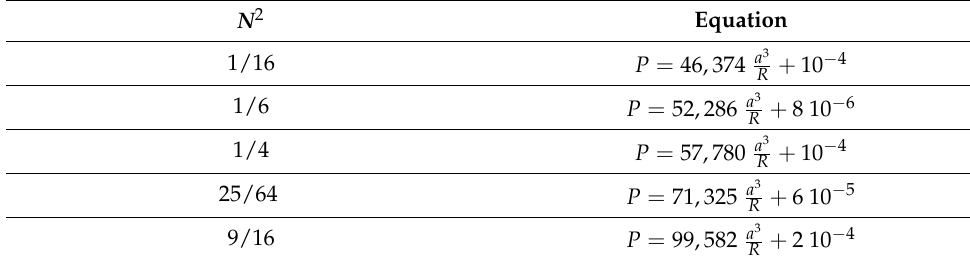
Figure 1. Plots of load ( P ) versus ( a 3 / R ) for different values of the coupling number N 2 . Table 2. Parameters of the line fit of the load ( P ) versus ( a 3 / R )